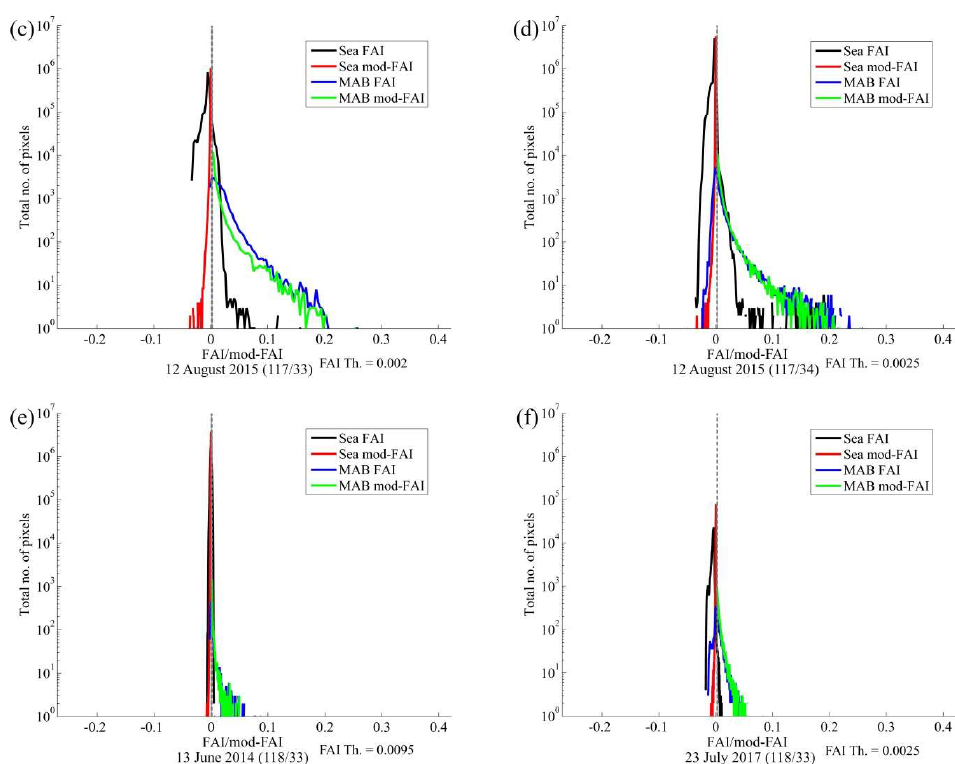
Figure 8. Changes in the distribution of macroalgae and sea pixels due to the application of modification to the FAI. Results of ( b ) to ( f ) are shown for the whole image areas of respective Landsat-8 images except ( a ) showing the results for the area in Figure 4e,f. Vertical hatch lines are shown along the modified FAI threshold values (mod-FAI). Remote Sens. 2018 , 10 , x FOR PEER REVIEW